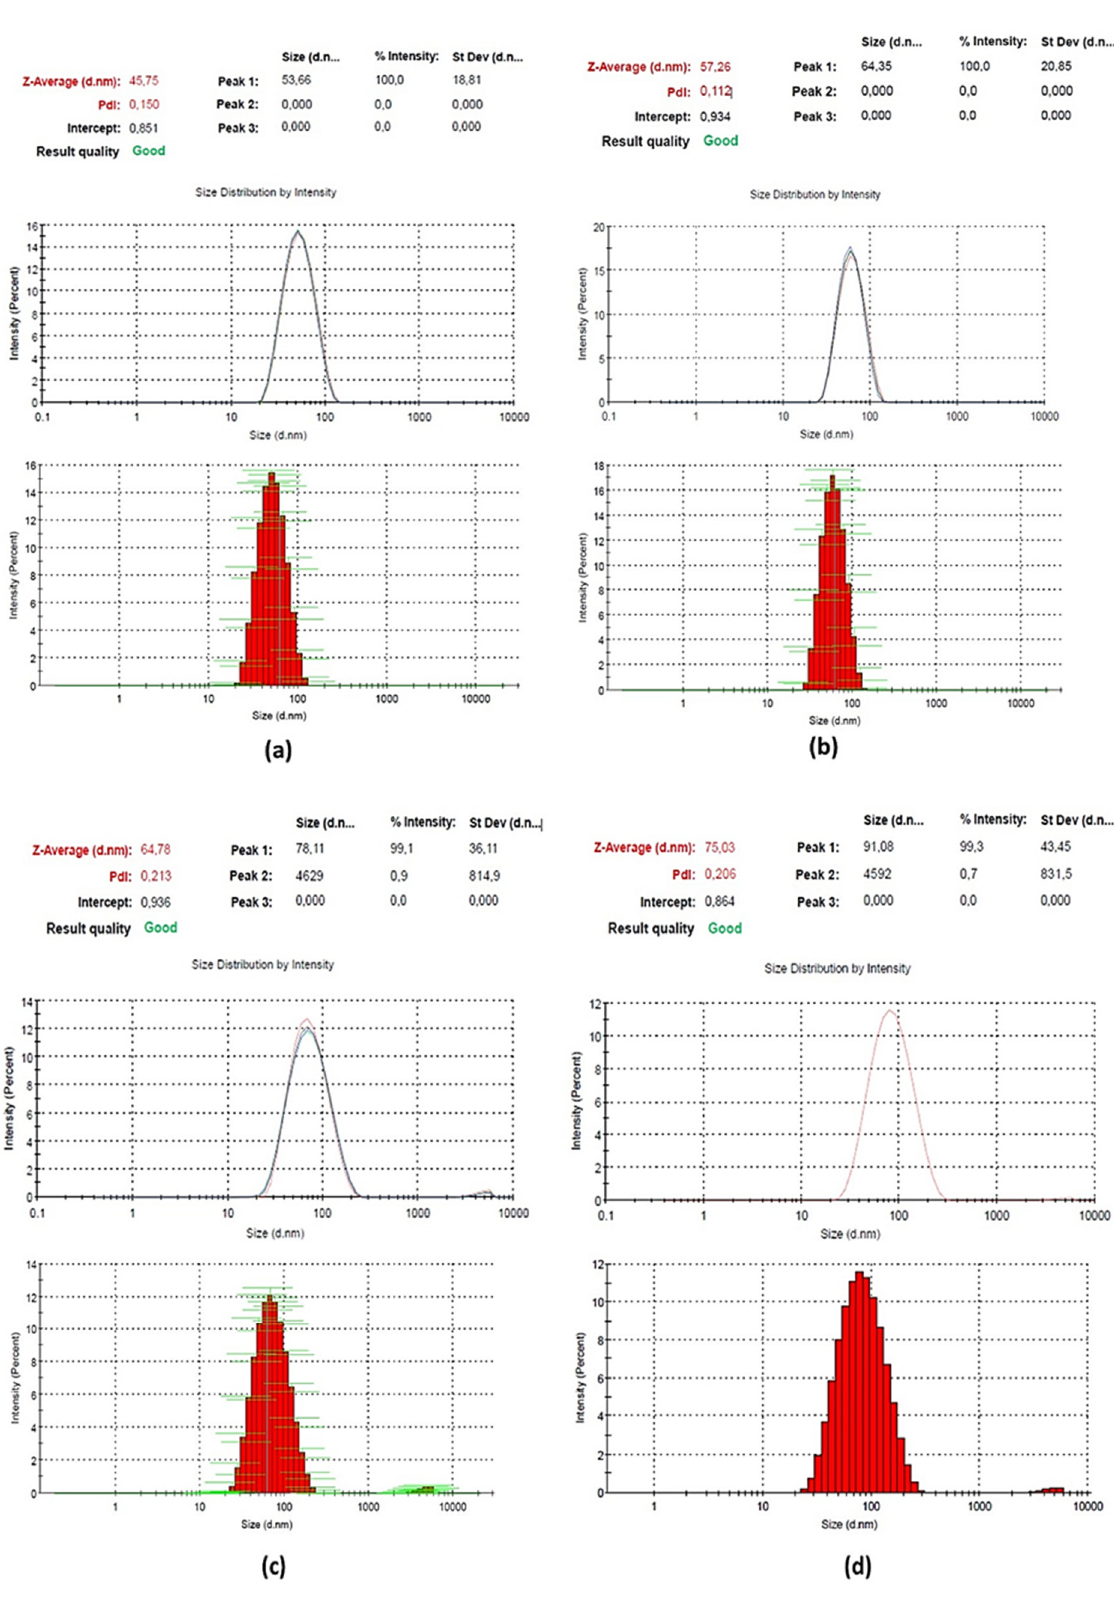
Figure 2. DLS histograms of ( a ) MNP, ( b ) MNP/TEOS, ( c ) MNP/TEOS/APTES, ( d ) MNP/TEOS/APTES/EDC/NHS/5-mC Ab.